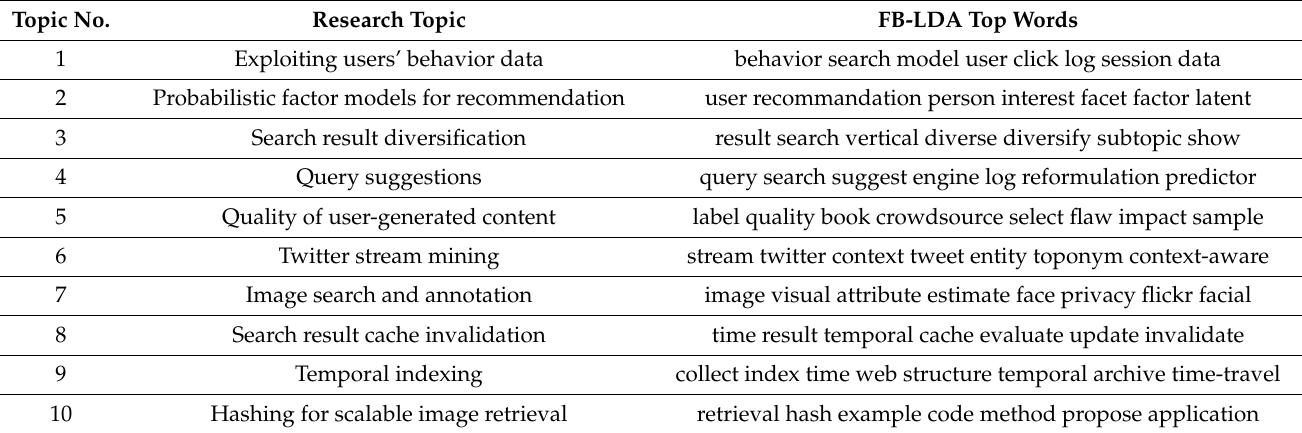
Table 8. FB-LDA results for SIGIR